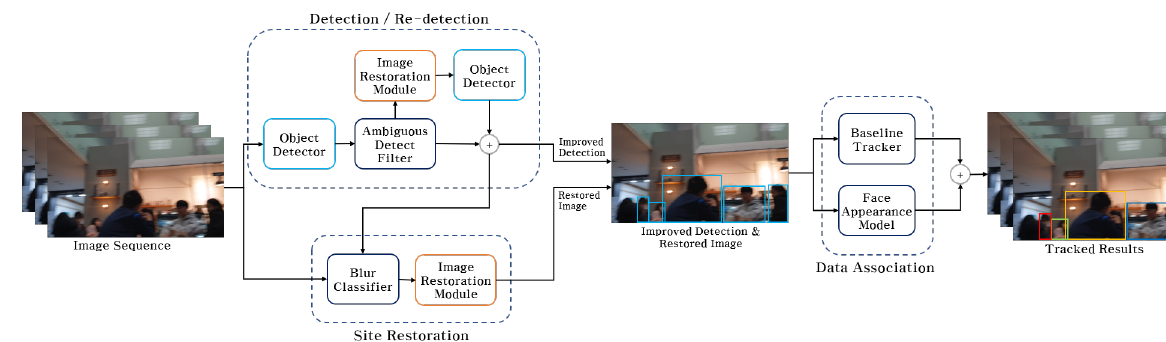
Figure 1. A schema of the proposed model. It illustrates the integration and work flow of our three